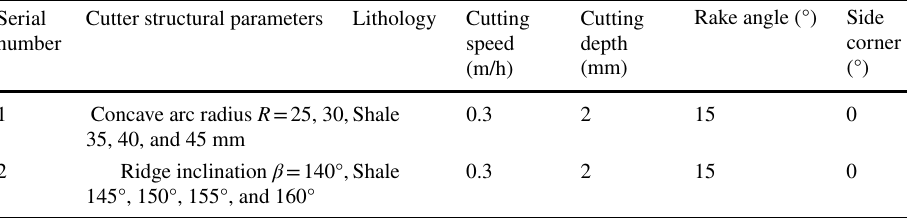
Table 2 Parameters of simulated rock breaking